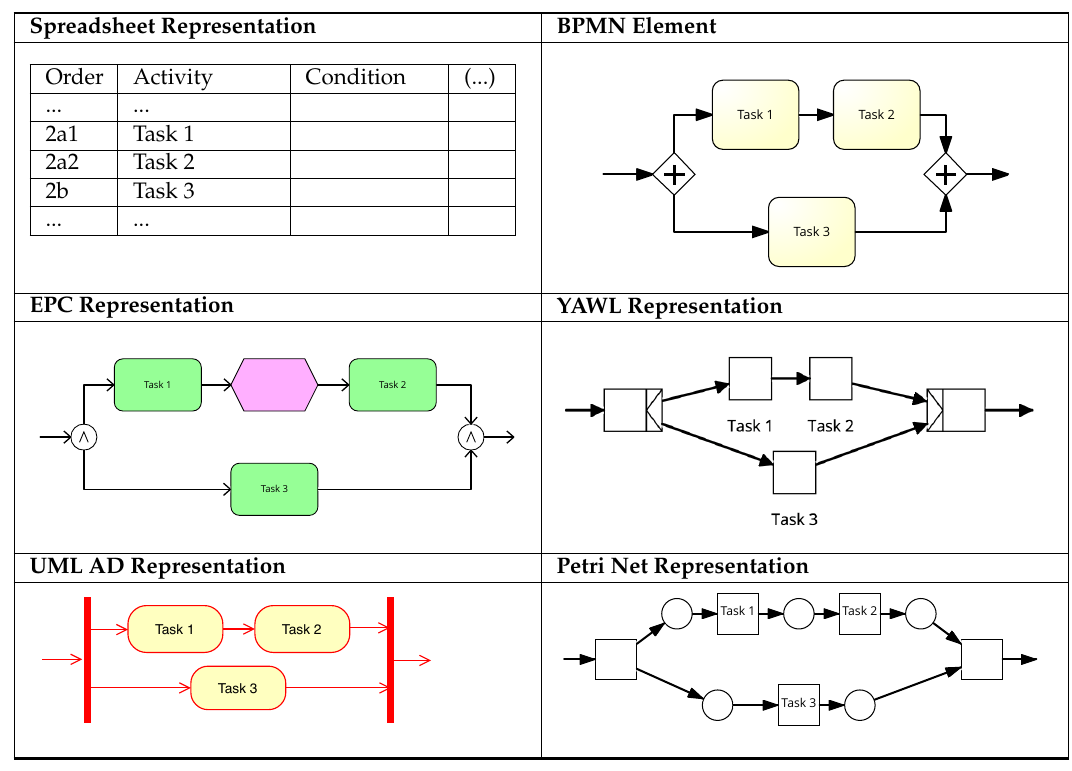
Table 9. AND-gateway example.